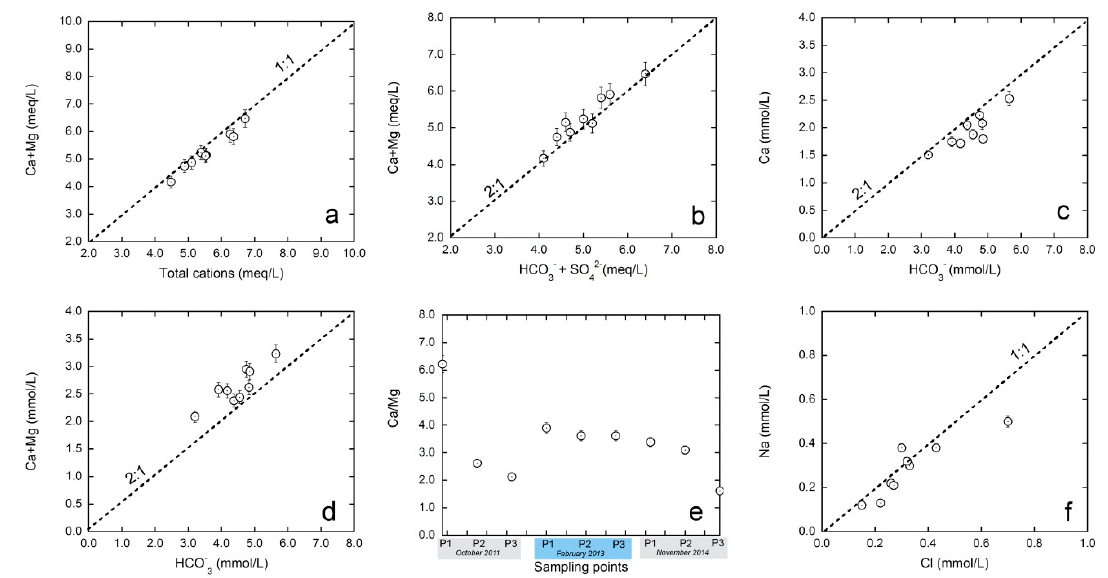
Figure 9. Correlation diagrams between Ca + Mg and total cations ( a ), Ca + Mg and bicarbonate+sulphate ( b ); Ca and bicarbonate ( c ); Ca + Mg and bicarbonate ( d ); Ca/Mg ratios of the sampling points ( e ) (background colors indicate different dates); and Na and Cl ( f